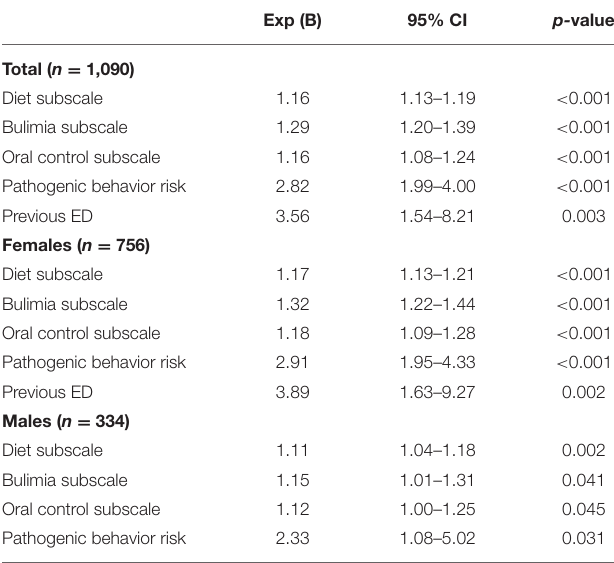
TABLE 4 | Logistic regressions analysis for the presence of ON risk, stratified by sex controlled for sport